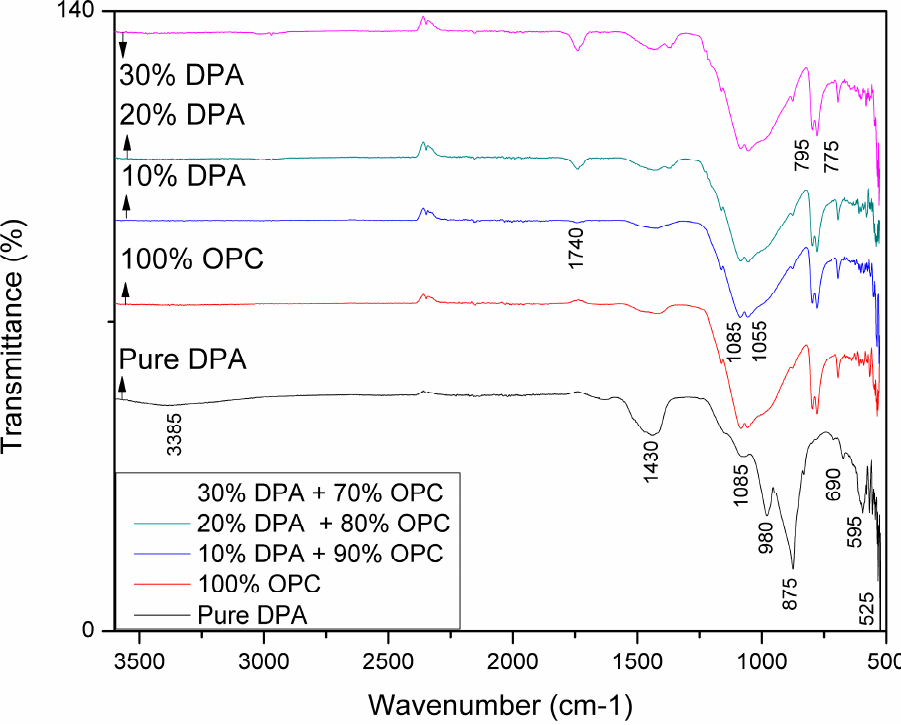
Figure 11. FT-IR spectra of pure DPA and binders at 28 days.